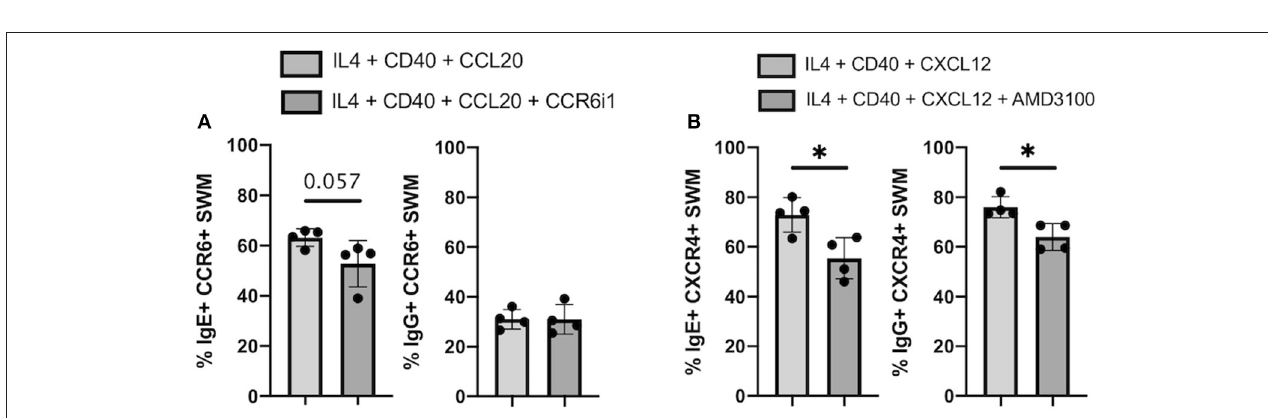
FIGURE 7 | Chemokine receptor inhibitors reduce IgE isotype switching. (A) Percentage of IgE + and IgG + of CCR6 + SWM after 10 days culture with 20ng/mL IL-4, 10 ug/mL anti-CD40 ± 20ng/mL CCL20 ± 5uM CCR6i1. (B) Percentage of IgE + and IgG + of CXCR4 + SWM after 10 days culture with 20ng/mL IL-4, 10 ug/mL anti-CD40 ± 100ng/mL CXCL12 ± 5 uM AMD3100. * p < 0.05 by Mann-Whitney